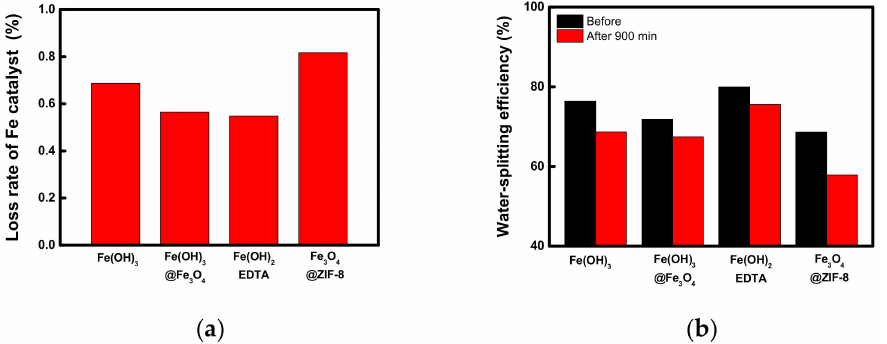
Figure 14. Comparisons of ( a ) loss rate of Fe catalyst and ( b ) changes in water-splitting efficiency of fabricated BPMs containing different catalysts after the elusion